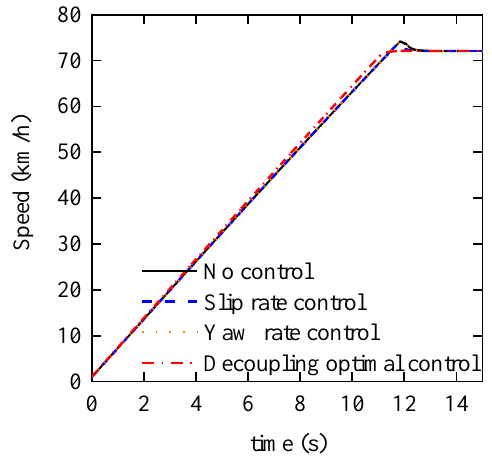
Figure 16. Vehicle speed. Figure 16. Vehicle